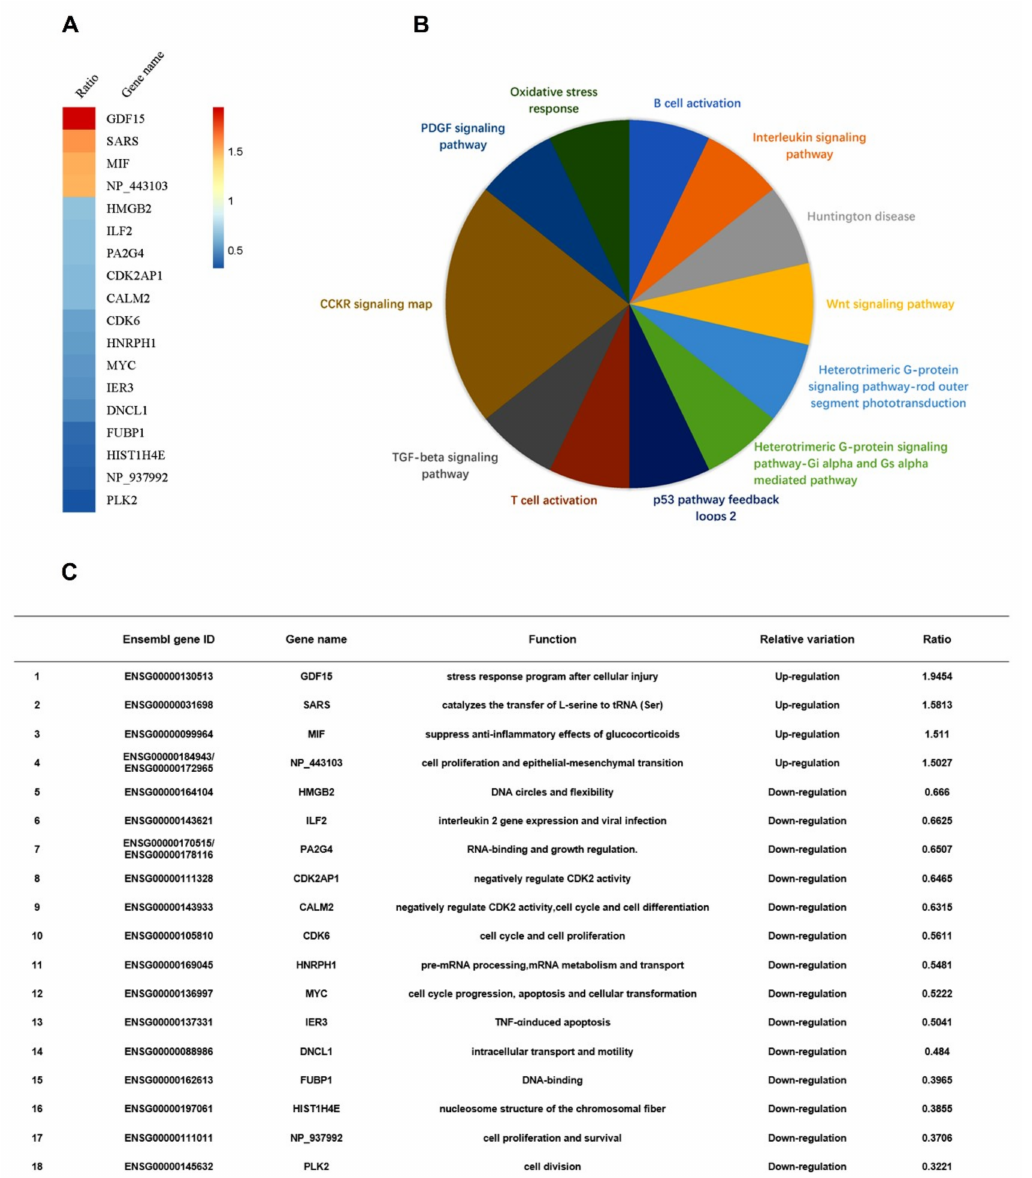
Figure 2. ILF2 expression is attenuated in EV71-infected cells. ( A ) The levels of di ff erentially-expressed gene mRNAs analyzed by microarrays of RD cells infected with or without EV71 (MOI = 0.5) for 12 h. Z-score analyses were used to choose the significant di ff erentially-expressed genes. The mRNAs of genes with more than 1.5-fold variations of expression levels were defined as di ff erentially-expressed genes. Intensity ratio (experimental group / control group) of genes was calculated and visualized in R software (version 3.4.4) with Pheatmap Packages (version 1.0.8). ( B ) Di ff erentially-expressed genes imported to the Protein Analysis Through Evolutionary Relationships Classification System to conduct pathway analysis. ( C ) Summary of Ensembl gene IDs, gene names, functions, and relative variations of the di ff erentially-expressed